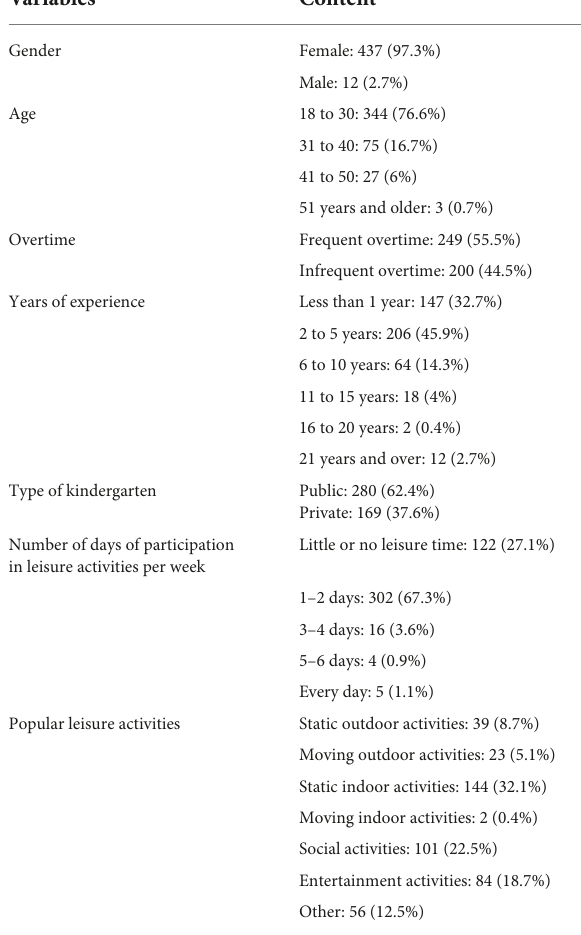
TABLE 1 Demographic details of